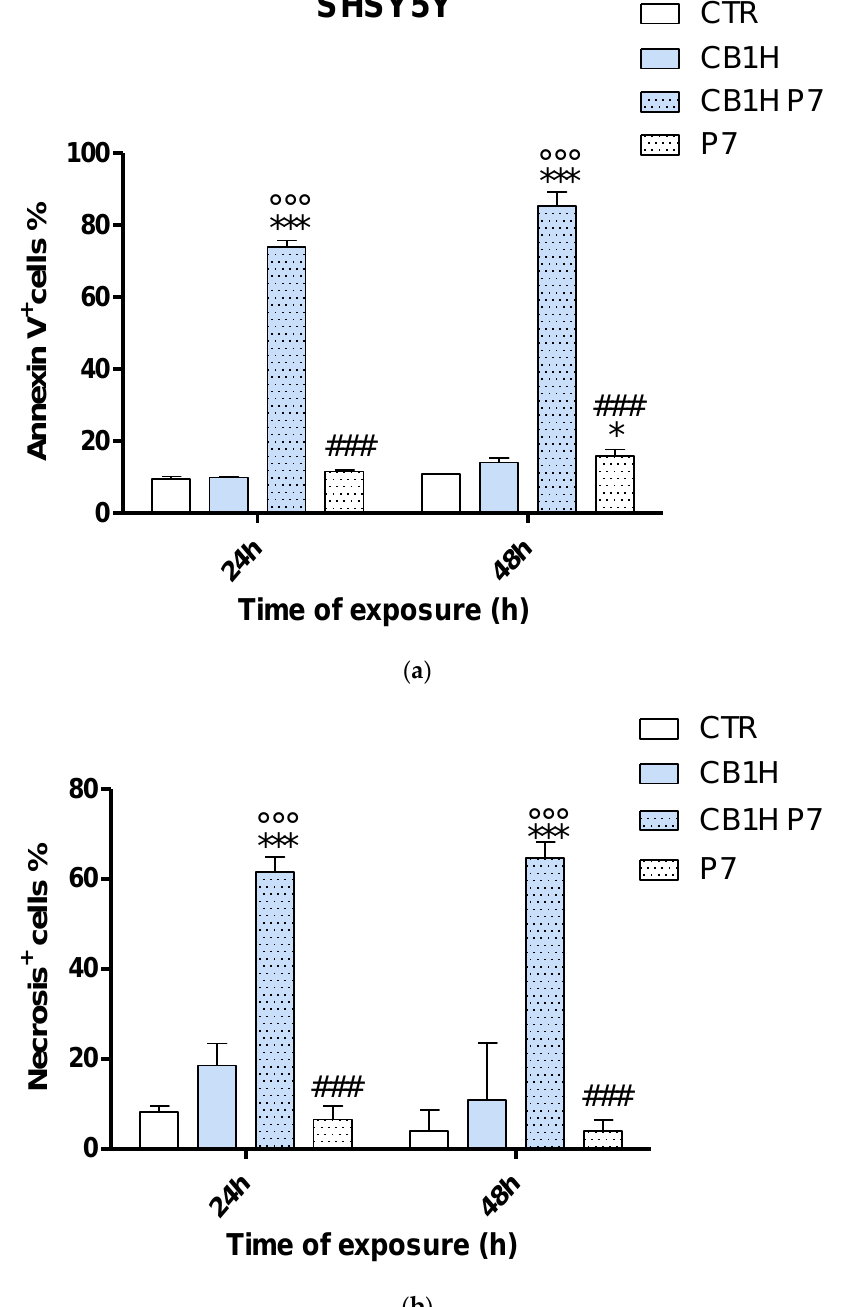
Figure 6. Time-dependent analysis of population of the SHSY 5Y cells with early-stage apoptosis ( a ) and with late-stage apoptosis/necrosis ( b ) detected by Annexin-V ( a ) and 4-AAD ( b ) staining. SHSY 5Y cells were grown in the presence or absence (CTR) of CB1H 20 µM, P7 0.57 µM and CB1H-P7 0.57 µM for 24 h and 48 h. Significance refers to control (*), CB1H (°), or CB1H-P7 (#). Specifically, p > 0.05 ns; p < 0.05 * (vs. CTR), ° (vs. CB1H), # (vs. CB1H-P7); p < 0.01 ** (vs. CTR), °° (vs. CB1H), ## (vs. CB1H-P7); p < 0.001 *** (vs. CTR), °°° (vs. CB1H, ### (vs. CB1H-P7). As can be seen in Figure 5 (IMR-32 cells), untreated cells (CTR) only slightly included 4-AAD and bonded with Annexin-V, thus showing low percentages of apoptosis both at 24 (9.0%) and 48 h (9.5%), and even lower percentages of necrosis (5.7% and 6.1%). Apoptosis was similar in untreated SHSY 5Y cells (9.5% and 10.9% at 24 and 48 h, respectively), while necrosis was slightly higher at 24 h (8.3%) and lower at 48 h (4.0%) (Figure 6). In